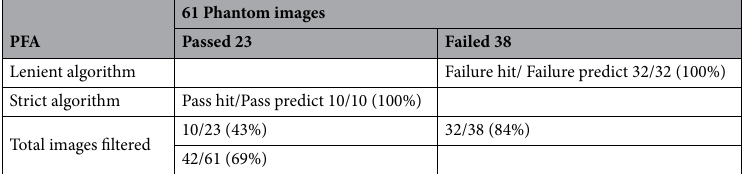
Table 5. Results after application of PFA in the external validation set. PFA, phantom image filtering algorithm.